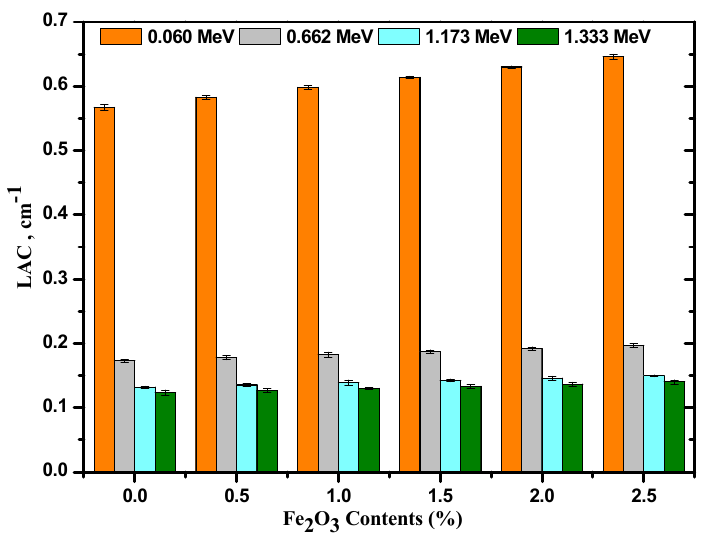
Figure 6. The relation between the LAC and the concentrations of Fe 2 O 3 nanoparticles. The experimental HVL values for the reference mortar and the mortar samples with Fe 2 O 3 nanoparticles are given in Figure 7. It was found that the HVL values for the four tested energies decrease as the amount of Fe 2 O 3 nanoparticles increases in the mortar. At 0.06 MeV, the HVL for the reference mortar is higher than the other mortar samples (it is 1.223 cm for the reference mortar and varied between 1.19 cm for MI-5 and 1.074 cm for MI-25). At 0.662 MeV, the HVL for the reference mortar is 4.002 cm and decreases to 3.898 cm due to the addition of 5% of Fe 2 O 3 nanoparticles, and to 3.524 cm due to the addition of 25% of Fe 2 O 3 nanoparticles. So, increasing the ratio of Fe 2 O 3 nanoparticles can lead to a notable reduction in the HVL. As we found in the previous figure, the energy of the photons also affects the HVL. It can be seen that the HVL increases significantly due to the increase in the energy from 0.06 to 1.333 MeV. For instance, for MI-5, the HVL varied between 1.190 and 5.468 cm between the lowest and highest investigated energies. So, the HVL at 1.33 MeV is almost 4.5 times the HVL for the same sample (i.e., MI-5) at 0.06 MeV. This result is also valid for the other mortars, where the HVL for MI-15 at 1.333 MeV is almost 4.6 times the HVL of the same mortar at 0.06 MeV.